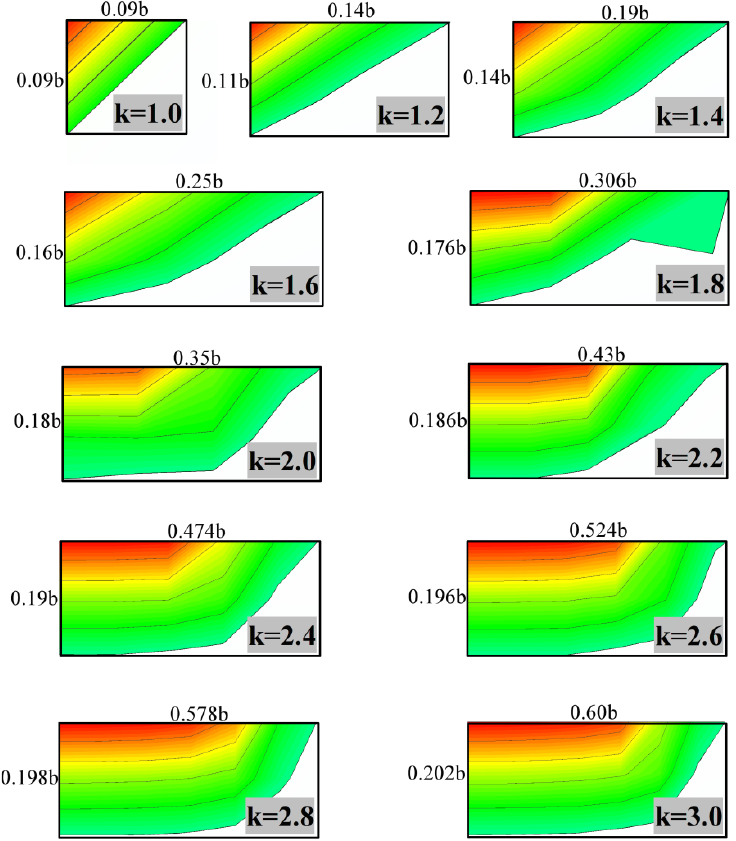
Figure 14. Change of the high-pressure area at the corners with the value of K .